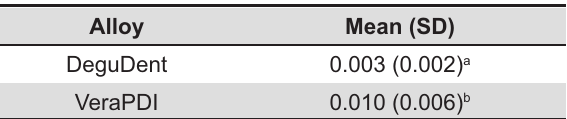
Table 2- Means and standard deviation (SD) of weight